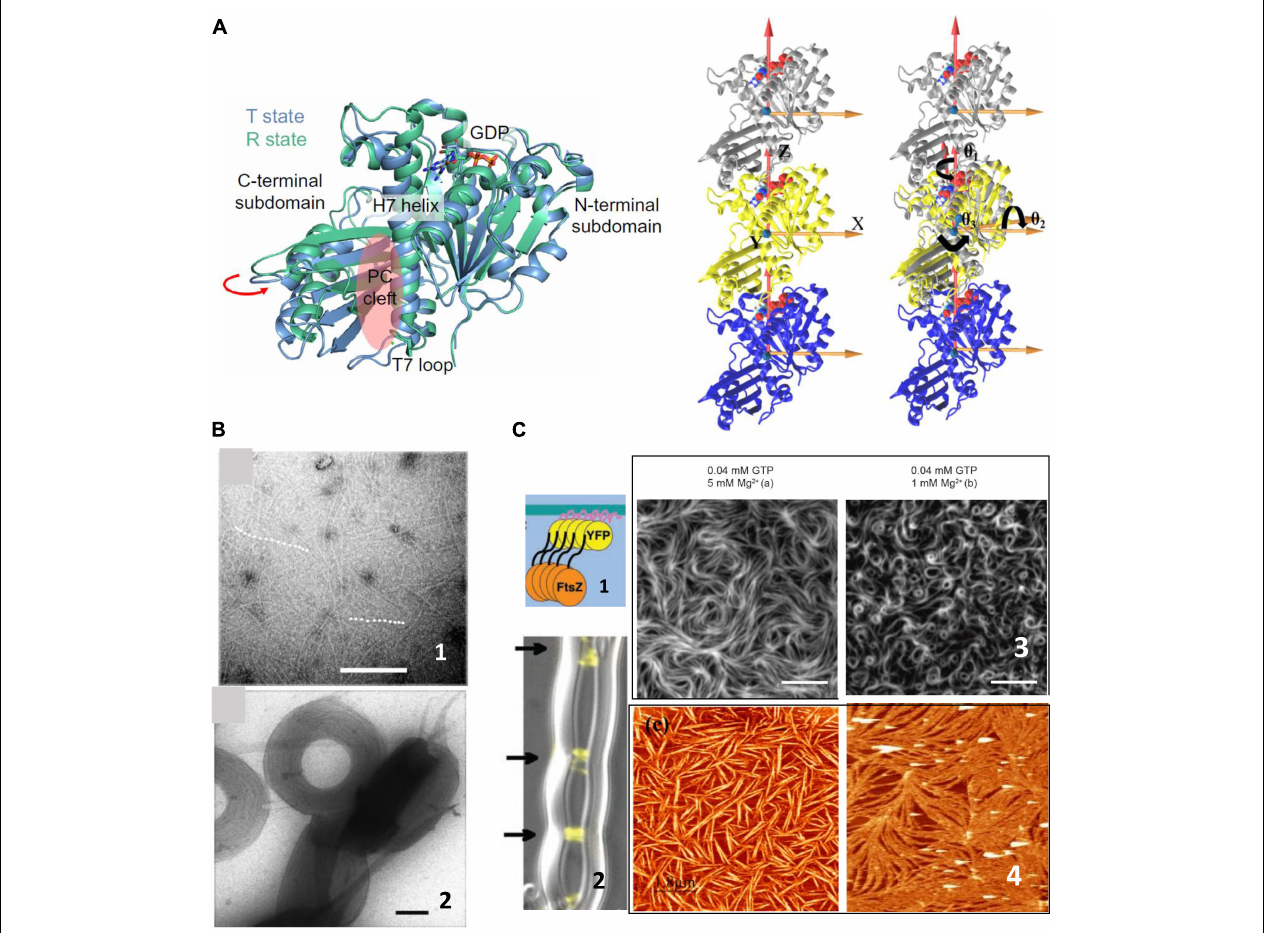
FIGURE 1 | FtsZ structure and polymerization in solution. (A) Left shows the two crystal structures of FtsZ from Staphylococcus aureus corresponding to the T and R state conformations in the same crystal, indicating the structural equilibrium of the two states (adapted from Fujita et al., 2017). The trimers on the right show the definitions of bending and twisting angles obtained from molecular dynamics simulations. The left trimer shows the coordinate system and the one on the right shows the bending angles, θ 1 (rotations around the Z axis), θ 2 (rotations around the X axis), and θ 3 (rotations around the Y axis), tracked by calculating the rotations of the top (silver) subunit to align the initial reference frame of the middle subunit (adapted from Lv et al., 2021). (B) Shows representative negative stained TEM images of FtsZ filaments in solution (1) and aggregates formed in the presence of crowding agents (2). Scale bar is 100 nm (adapted from Popp et al., 2009). (C) Shows surface confined FtsZ polymers. (1) Show a chimeric FtsZ containing a fluorescent protein and a membrane targeting sequence (MTS) on liposomes (2) (adapted from Osawa et al., 2008) and on planar supported membranes (3) (adapted from Ramirez-Diaz García-Soriano et al., 2018). Scale bars are 5 µ m. (4) Shows Atomic Force Microscopy images of FtsZ filaments attached covalently to a lipid membrane (left) (adapted from Encinar et al., 2013) or bound through the protein ZipA (right) (adapted from Mateos-Gil et al., 2012a). Scale bars are 2 µ